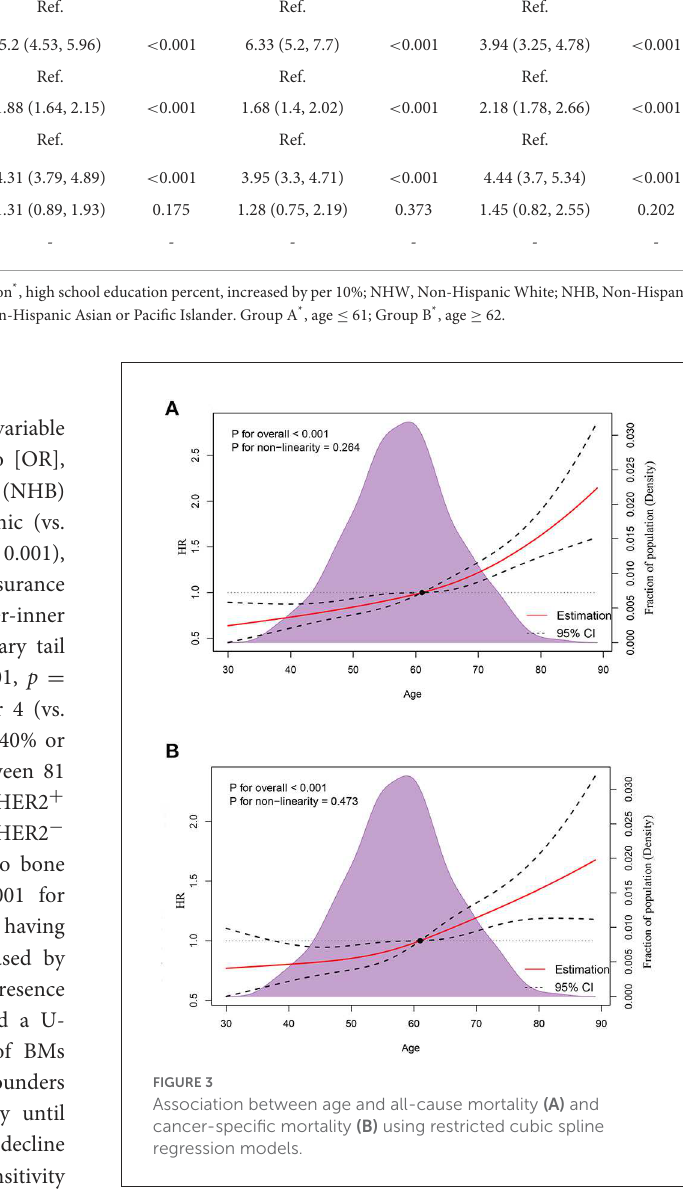
Age and mortality